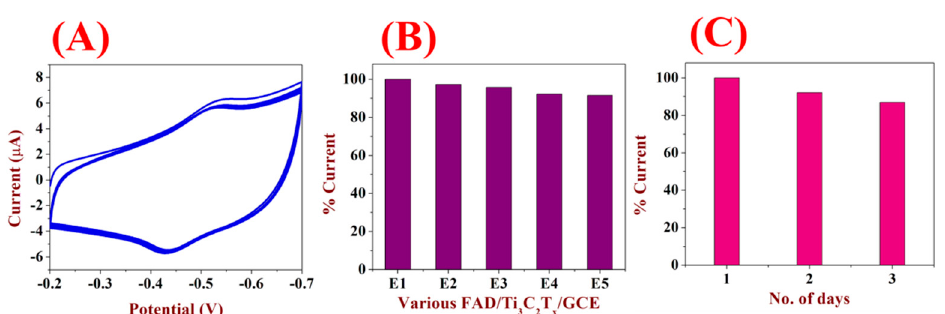
Figure 9. ( A ) CVs were recorded using the FAD/Ti 3 C 2 T x /GCE in 0.1 M PBS for the 50 continuous potential cycles at a scan rate of 50 mV/s. ( B ) The reproducibility of the five different FAD/Ti 3 C 2 T x /GCE’s were tested in 0.1 M PBS and the corresponding reduction current percentages were noted. ( C ) The repeatability of the FAD/Ti 3 C 2 T x /GCE was studied for continuous usage for 3 days in 0.1 M PBS and the changes in the reduction peak currents were recorded.